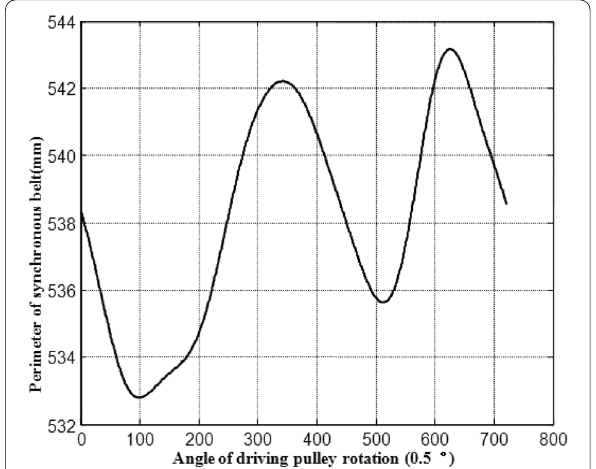
Figure 10 Belt length variation curve after manual optimization of tension pulley pitch